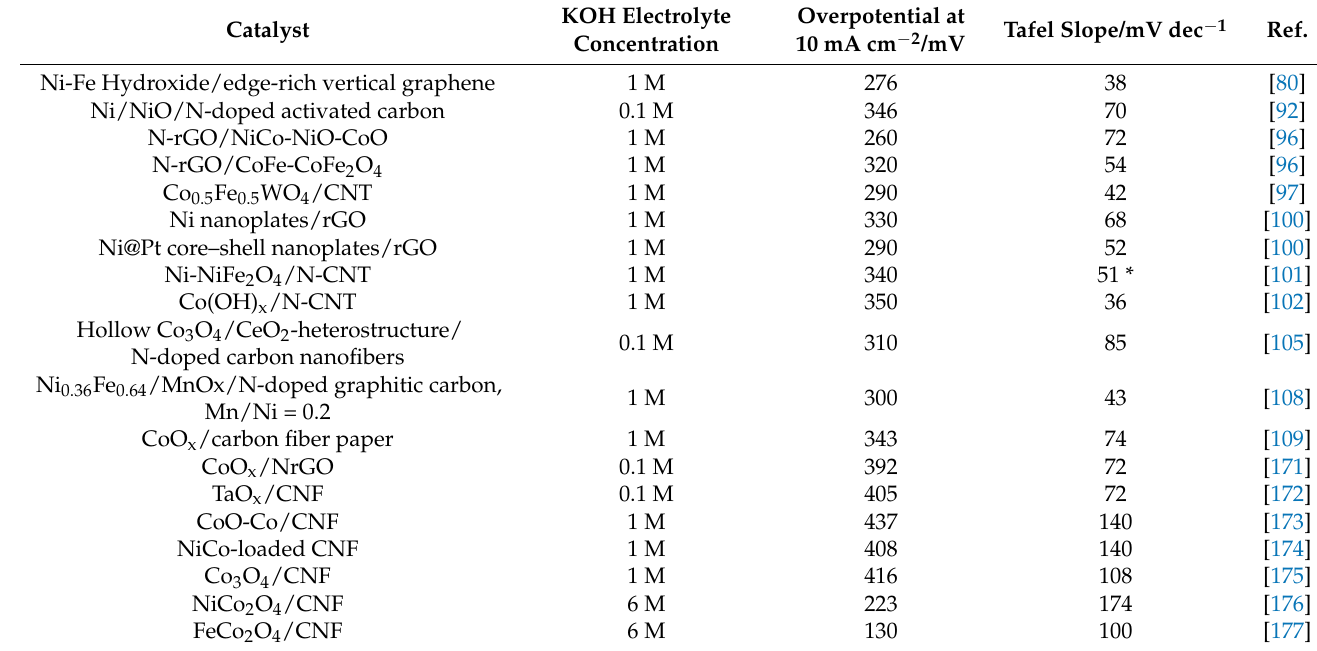
Table 3. Selection-comparison of carbon—metal hydroxides/oxyhydroxides/oxides.